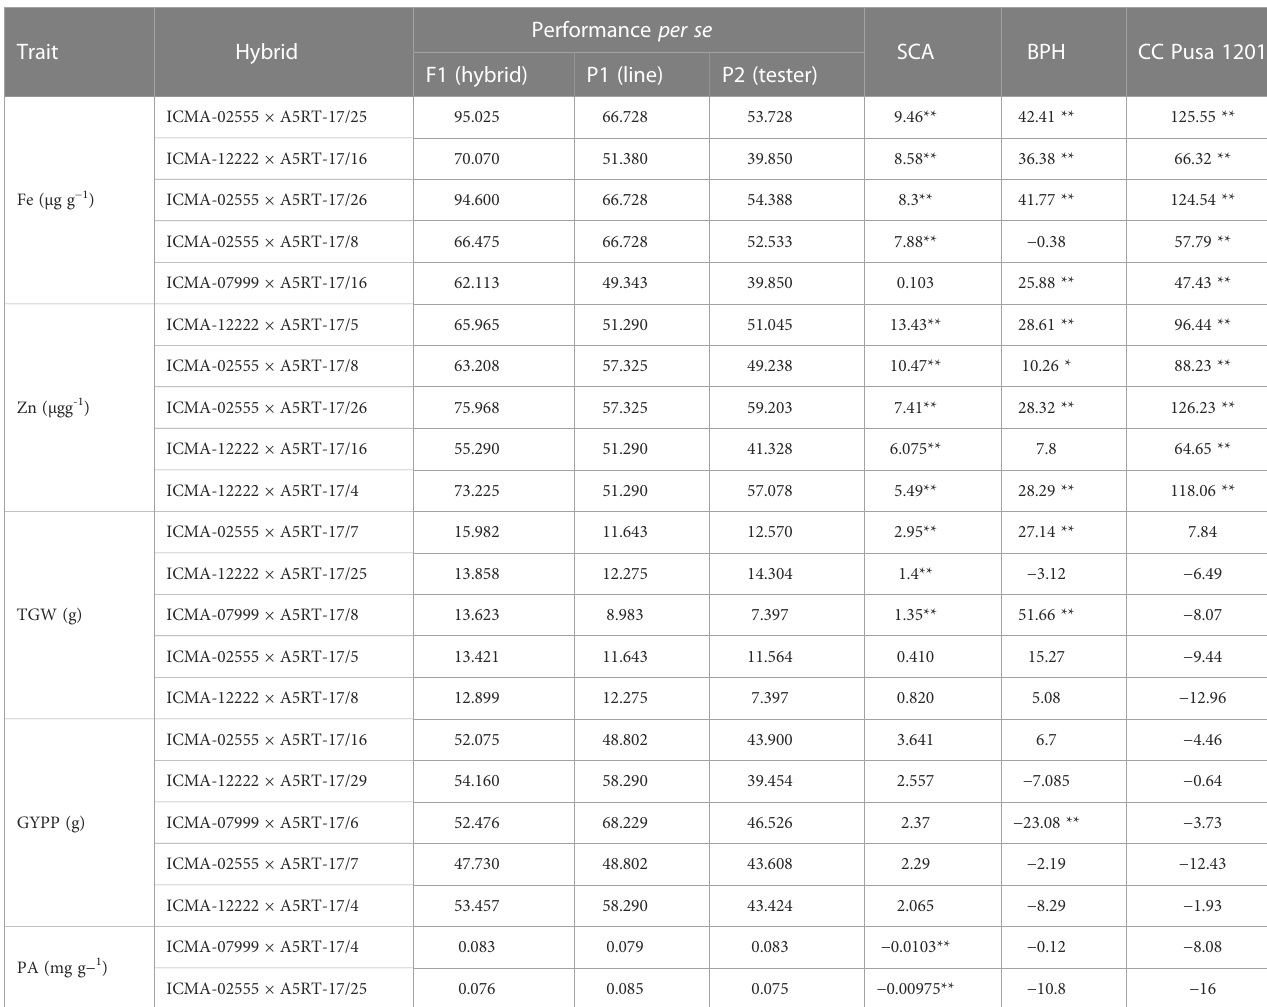
TABLE 4 Performance per se , speci fi c combining ability (SCA), better-parent heterosis (BPH) and standard heterosis (SH) of fi ve top rank hybrids for the traits studied of pearl millet across two environments.